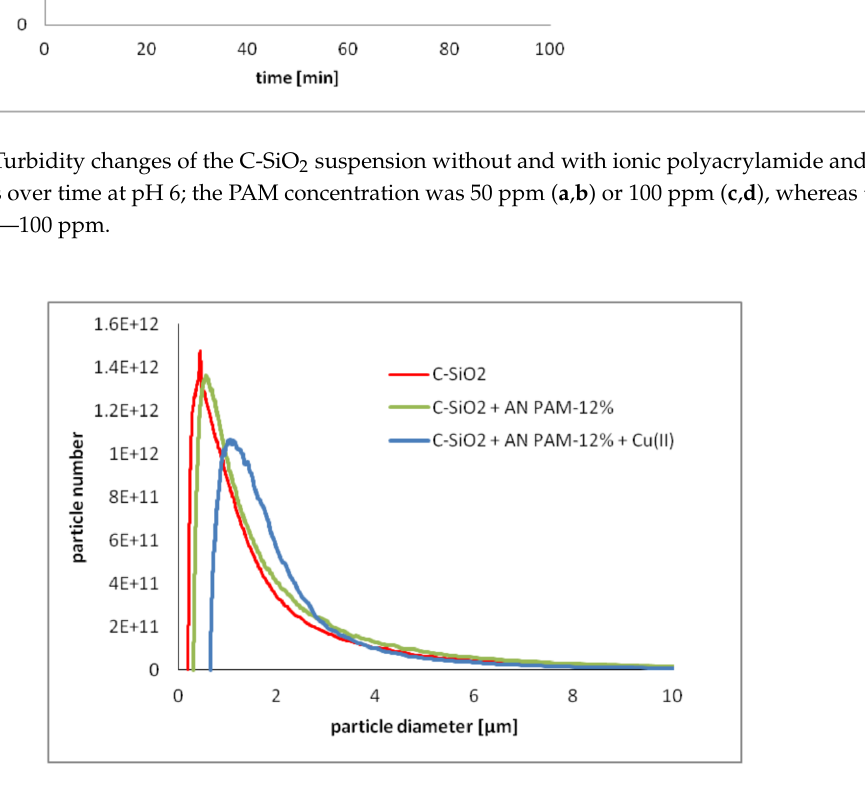
Figure 7. The particle number vs. particle diameter for the C-SiO 2 suspension without and with AN PAM-12% and / or Cu(II) ions at pH 6; the PAM concentration was 50 ppm, whereas the Cu(II) one—50